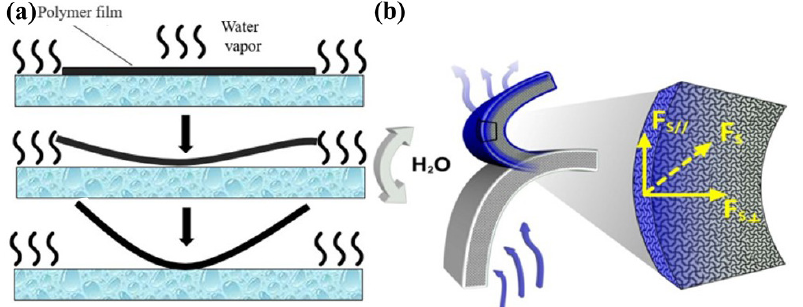
Figure 6. ( a ) Schematic diagram of polymer film with water vapor. ( b ) Schematic representation of cellulose stearate film with the effect of